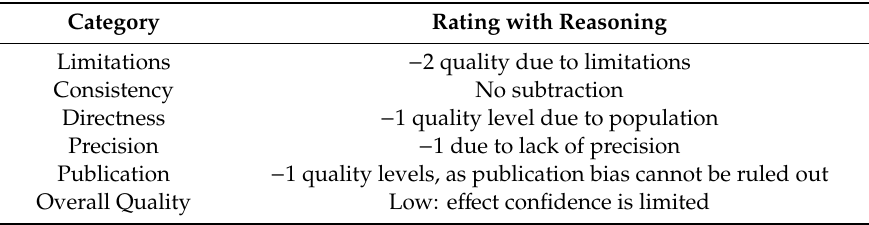
Table 3. Overall assessment of quality in seven studies (2763 participants in total) in the systematic review of e ff ectiveness of prevention interventions for adolescents from ethnic / racial minorities using the Grading of Recommendations Assessment, Development and Evaluation